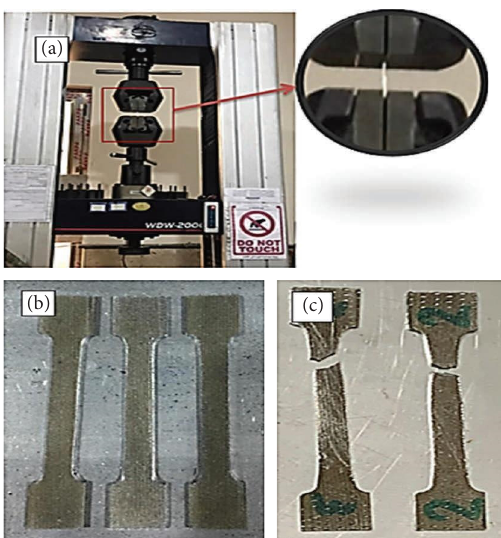
Figure 10: (a) Te tensile testing machine for tensile strength. (b) Samples before testing. (c) Samples after testing.